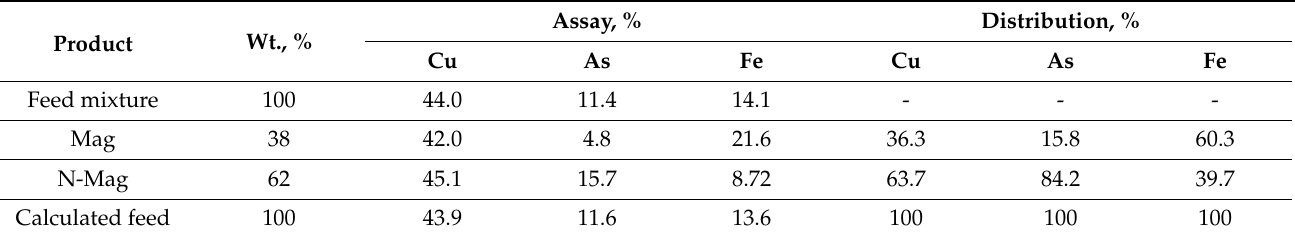
Table 3. XRF assays and distributions of magnetic separation feed and products of Chalcopy- rite/Enargite system after microwave treatment.